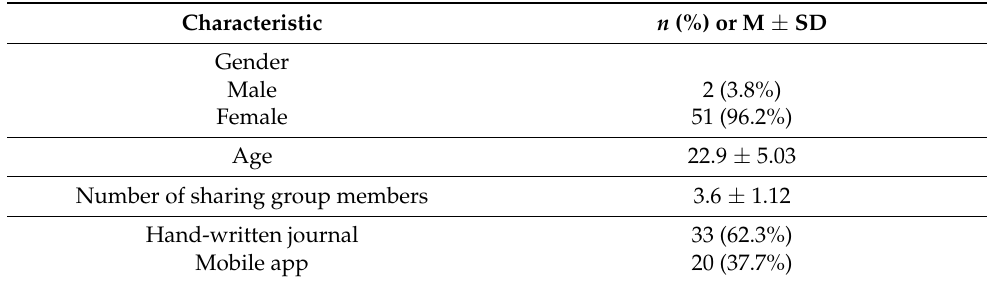
Table 1. General Characteristics of Participants ( n =